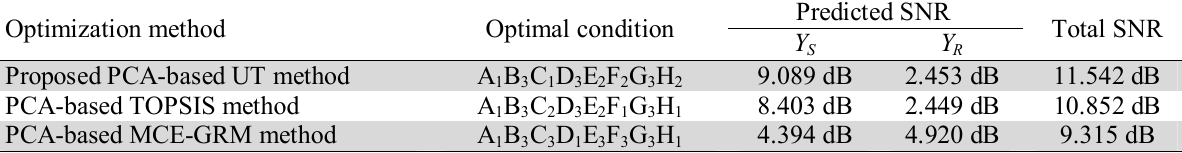
Predicted SNR values at the optimal conditions derived by the proposed and other PCA-based